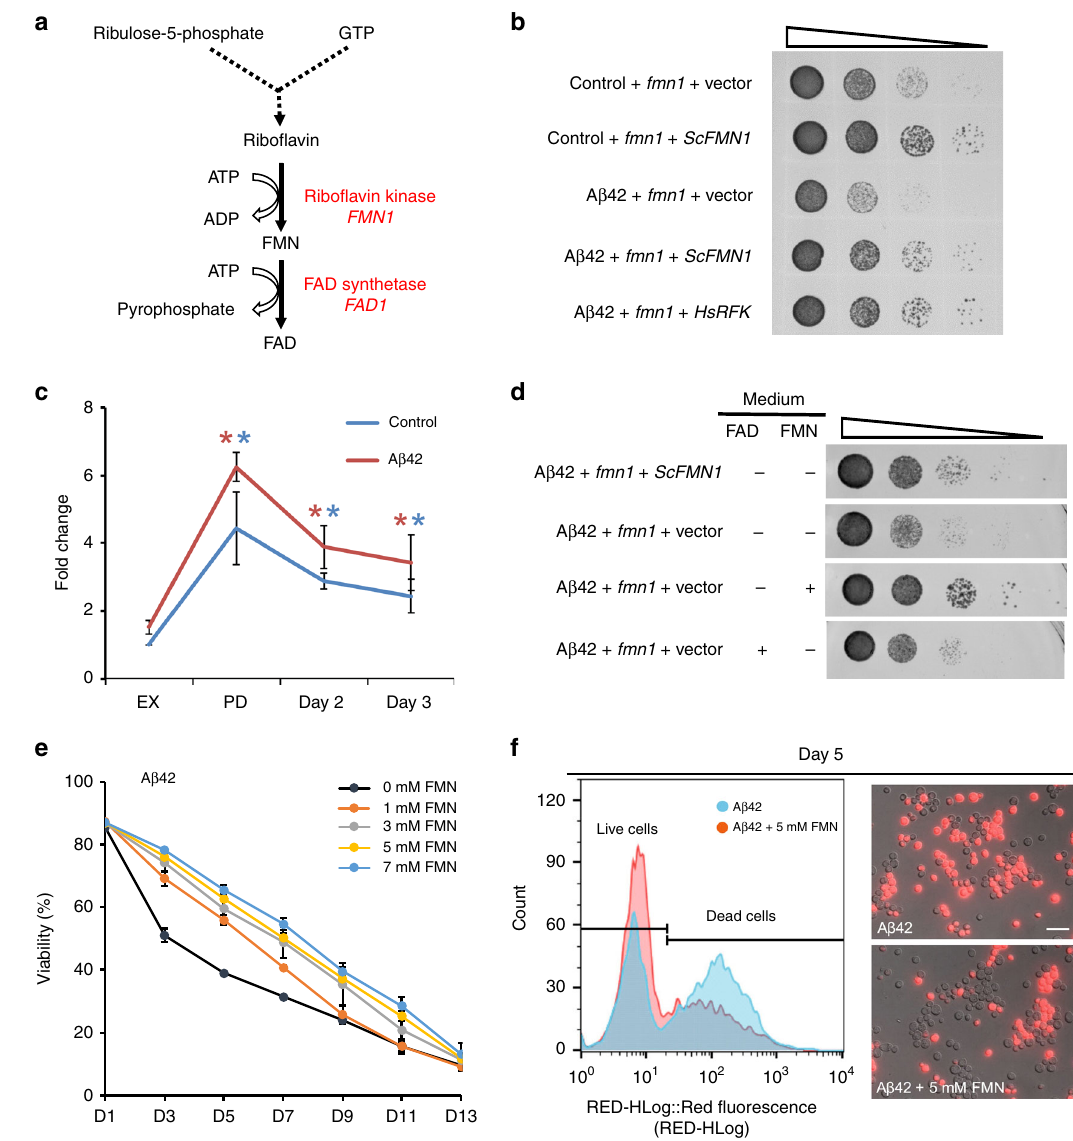
RED-HLog::Red fluorescence Fig. 3 Ribo fl avin kinase and its metabolic product FMN reduce A β 42 toxicity. a Schematic illustration of the ribo fl avin biosynthesis metabolic pathway. FMN, fl avin mononucleotide; FAD, fl avin adenine dinucleotide. b Complementation assays to con fi rm fmn1 mutant is causal towards increasing A β 42 sensitivity. Vector: MoBY empty plasmid; ScFMN1 : pFMN1-MoBY plasmid; HsRFK : P416 GPD-human RFK plasmid. c FMN1 mRNA expression during exponential growth (EX), post-diauxic shift phase (PD) and stationary phase (day 2 and day 3). Results from qPCR are normalized to EX of each strain and shown as the average values ± SD from three independent biological replicates. Asterisks (*) indicate signi fi cant differences compared to EX in both A β 42 (red) and control (blue) strains ( p < 0.05). d Ten-fold serial dilutions of the A β 42 expression strain with fmn1 mutation carrying the aforementioned plasmids with supplementation of 5 mM FAD or 5 mM FMN in the medium. e Survival of the A β 42 strain during stationary phase with different concentrations of FMN supplemented. Viability is shown as the fraction of propidium iodide (PI) negative cells ( n = 3 ± SD). f Flow cytometry and fl uorescence micrographs of PI staining in the A β 42 strain after 5 days of cultivation. Cells that are stained red represent nonviable cells. Scale = 10 µ m. Source data are provided as a Source Data fi